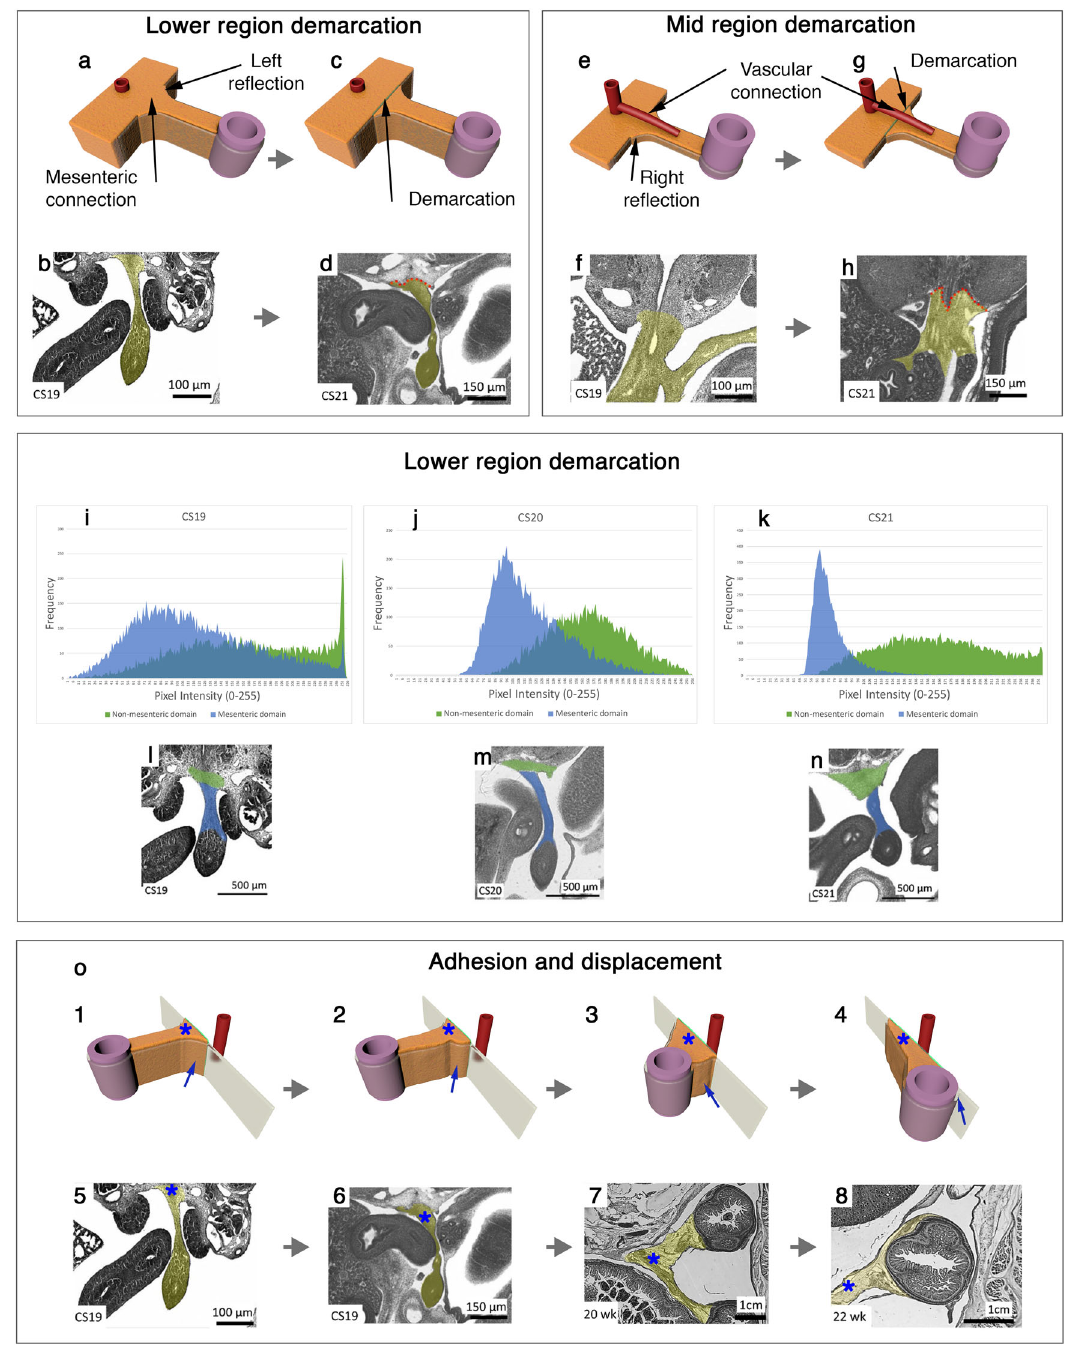
Fig. 2 The mesentery and posterior abdominal wall. a – d Photographs and corresponding photomicrographs demonstrating continuity between lower region mesentery and posterior abdominal wall. e – h Photographs and corresponding photomicrographs demonstrating continuity between mid-region mesentery and posterior abdominal wall. i – k Histograms demonstrating brightness values of developing mesentery and posterior abdominal wall. l – n Photomicrographs from which histograms were generated. o1 – 4 Panel demonstrating the relationships between the mesentery ( * ) and posterior abdominal wall during development. The mesothelial junction between both is indicated ( arrow ). o5 – 8 Photomicrographs demonstrating histological correlates for